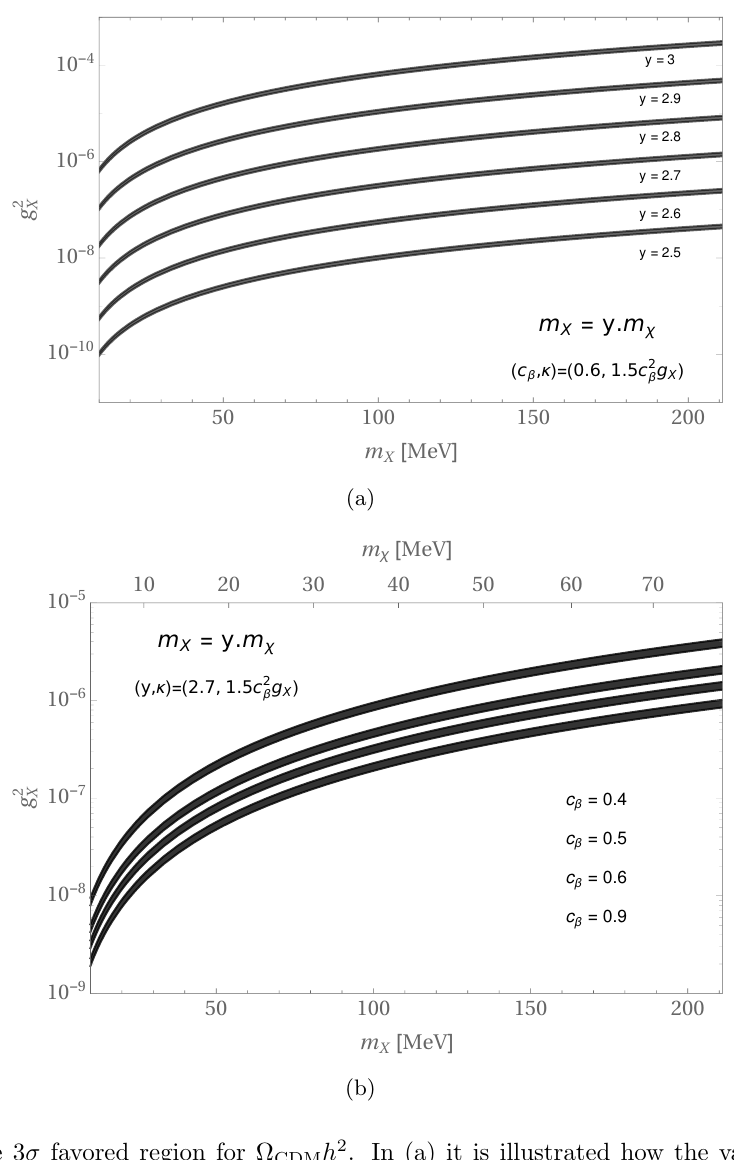
Figure 8 . The 3 (cid:27) favored region for (cid:10) CDM h 2 . In (a) it is illustrated how the variations in the relation m X = ym (cid:31) move the allowed region. In (b), the lines are less sensitive under small variations of c (cid:12) . The region below each line corresponds to overabundant (cid:10) (cid:31) h 2 . with jMj 2 = j P M j 2 . The dominant contribution to A ( (cid:18) ) originates from V V = (cid:13);Z;X